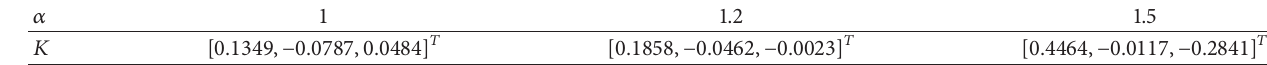
Table 2: Estimator matrix 𝐾 for different fractional orders 𝛼